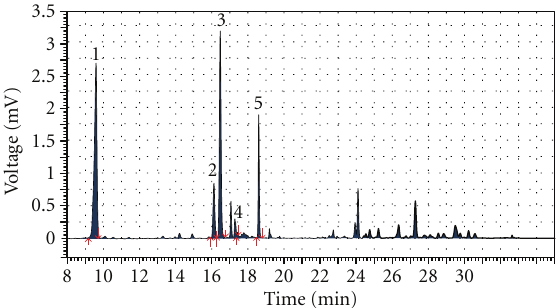
Figure 1: HPLC chromatogram of Hypericum leptophyllum meth- anolic extract detected by UV at 353 nm wave length. Peak iden- tified: 1—chlorogenic acid (retation time ( t R )—9.61min.),